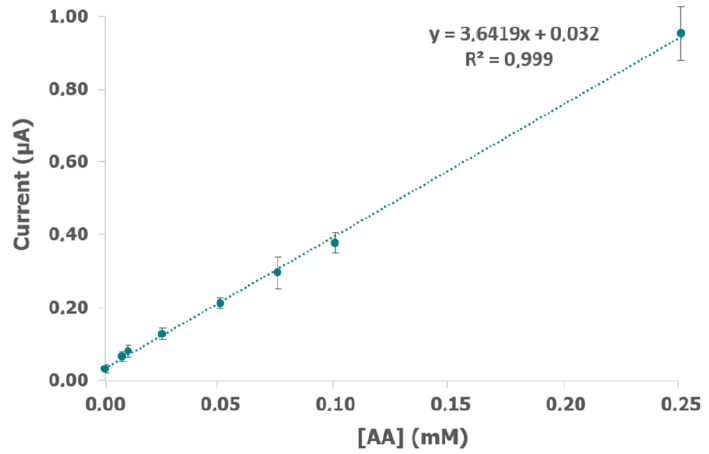
Figure 3. Calibration plot of AA obtained after applying +0.40 V for 60 s with different concentrations of acetaldehyde (AA) and 0.14 U/mL ALDH, 0.14 U/mL DP, 1 mM NAD + , 1 mM K 3 [Fe(CN) 6 ], and 0.1% BSA in 0.1 M phosphate and 0.1 M KCl buffer solution (pH 8).